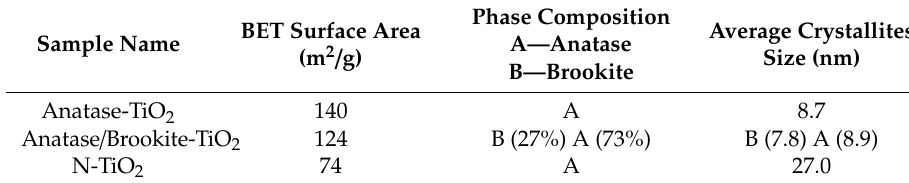
Figure 6. Photocatalytic decomposition of acetaldehyde in the circulated flow reactor under UV irradiation on TiO 2 samples prepared by a sol-gel method, the initial concentration of acetaldehyde was around 1800 ppm [35]. Table 1. Characteristics of the samples prepared by a sol-gel method [35].